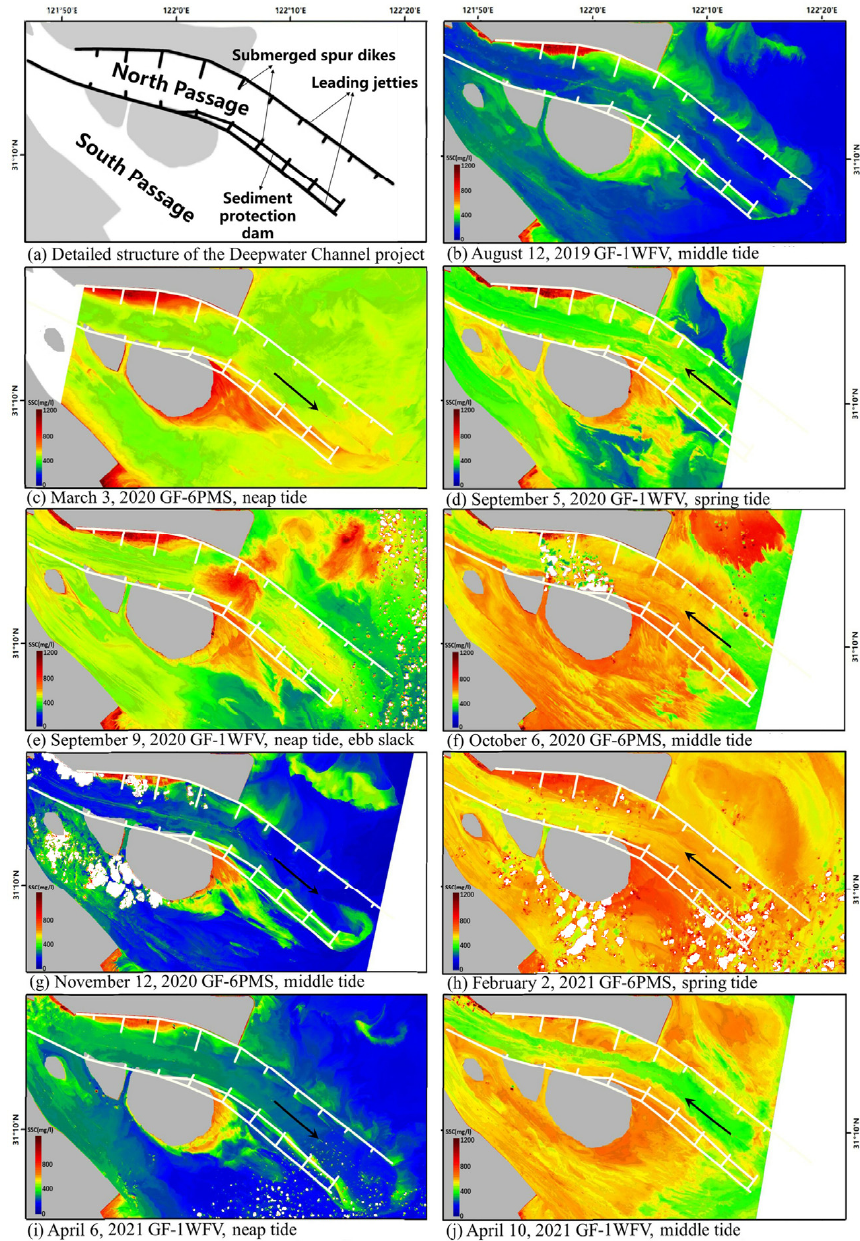
Figure 5. SSC distribution in the sand blocking